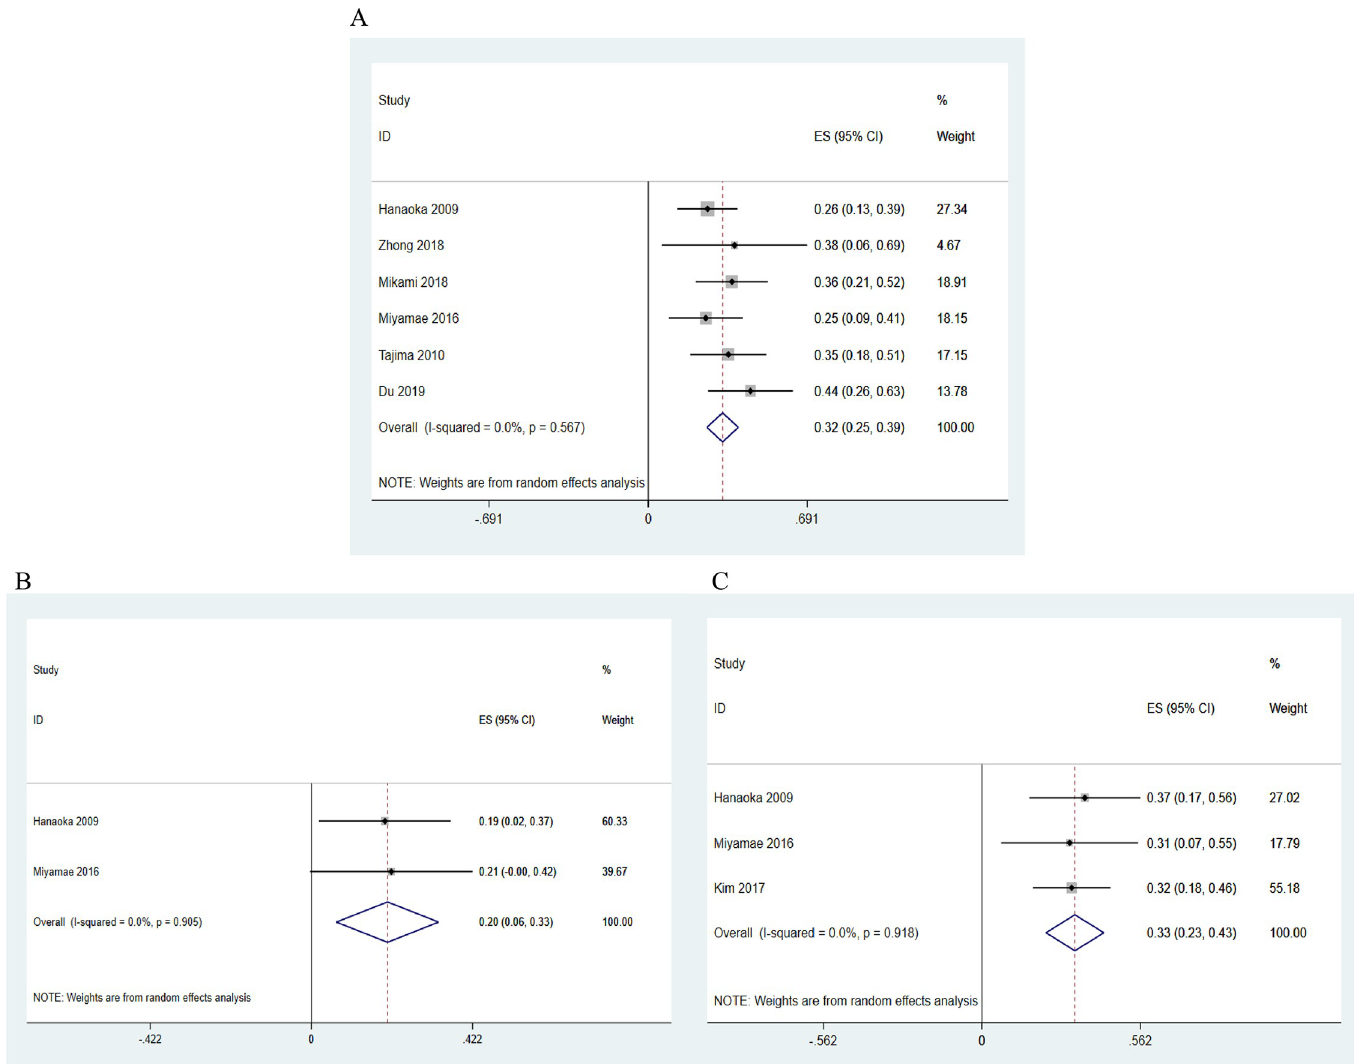
Fig 4. The rate of LNM in submucosal gastric cancer patients: (A) mixed type, (B) predominantly differentiated mixed type (MD), and (C) predominantly undifferentiated mixed type (MU).